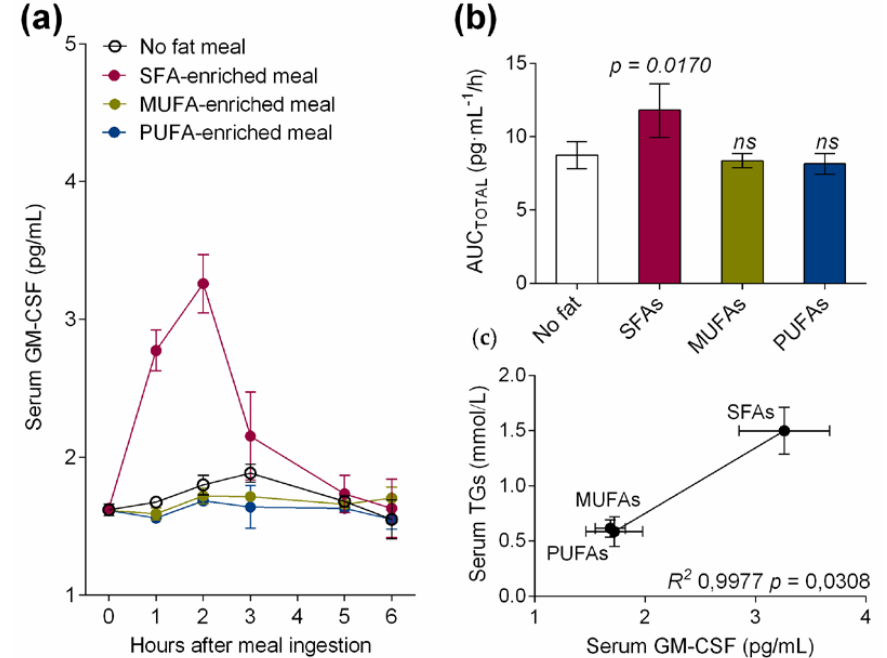
Figure 1. ( a ) Serum granulocyte / macrophage colony-stimulating factor (GM-CSF) levels at fasting and at the postprandial period after the administration of a control meal (with no fat) or high-fat meals enriched in saturated fatty acids (SFAs), monounsaturated fatty acids (MUFAs) or MUFAs + omega-3 long-chain polyunsaturated fatty acids (PUFAs) in healthy subjects. ( b ) Area under the curve of serum GM-CSF during postprandial period in response to test meals. ( c ) Correlation between postprandial serum GM-CSF levels and serum triglycerides (TGs) in healthy subjects after administration of test meals. Values are presented as means ± SD ( n = 6).